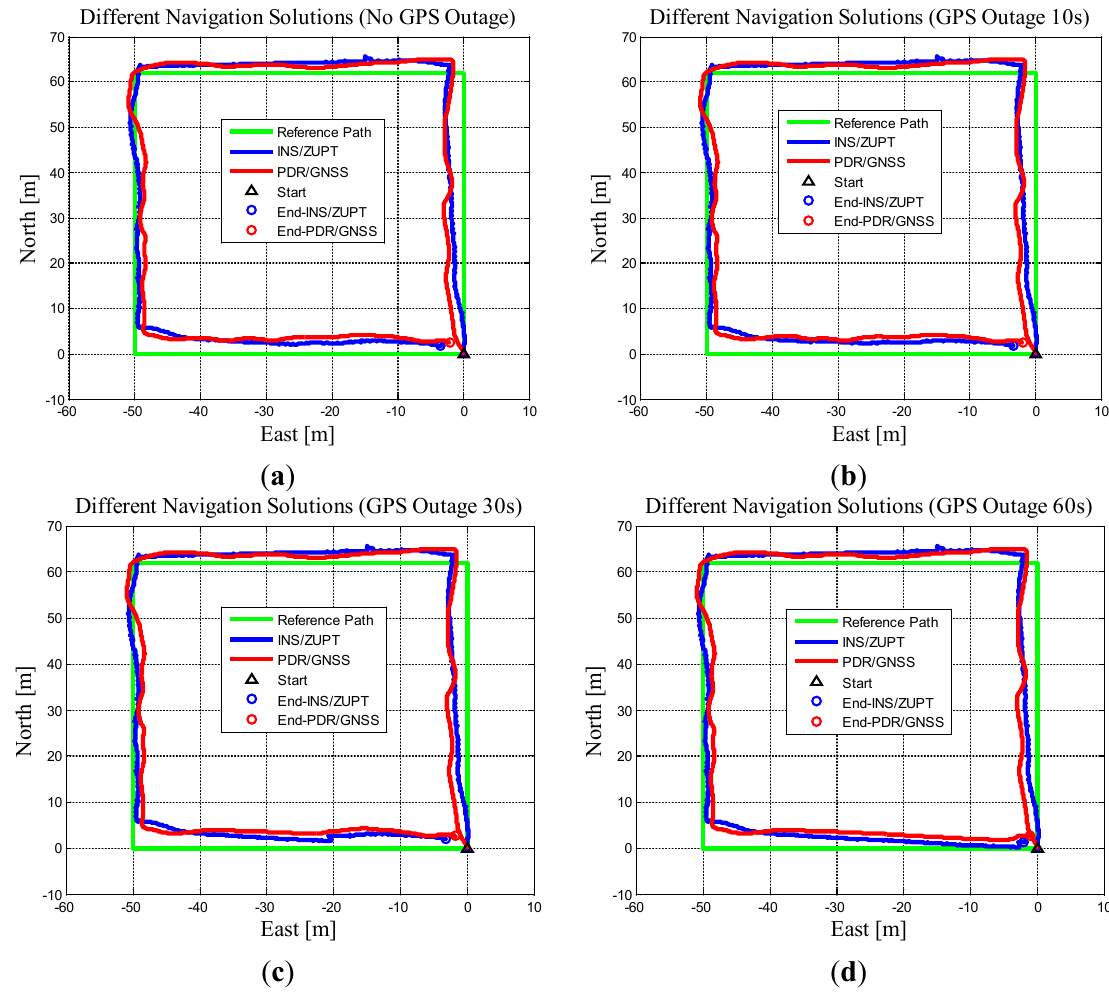
Figure 6. Two systems’ navigation solutions with state constraint for simulated GPS outage of ( a ) 10 s; ( b ) 20 s; ( c ) 30 s; ( d ) 40